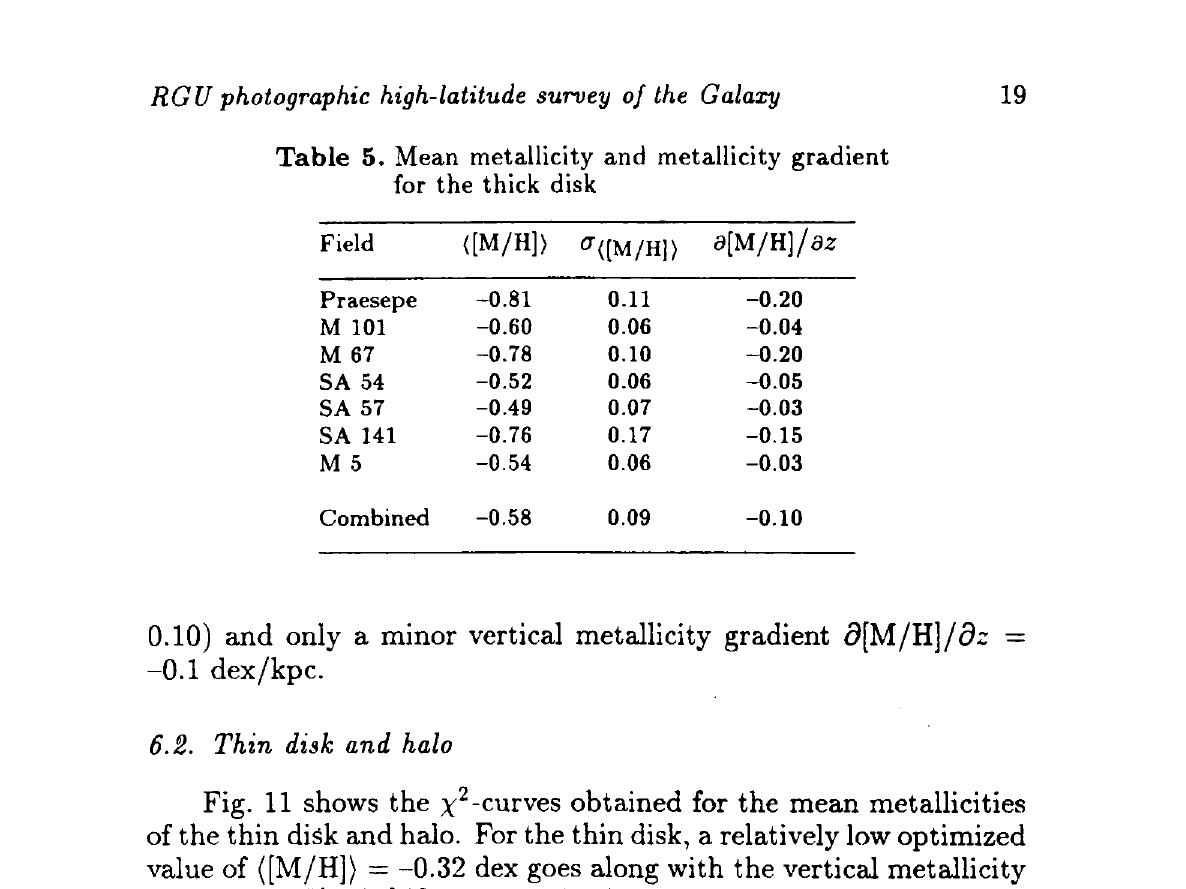
Table 5. Mean metallicity and metallicity gradient for the thick disk